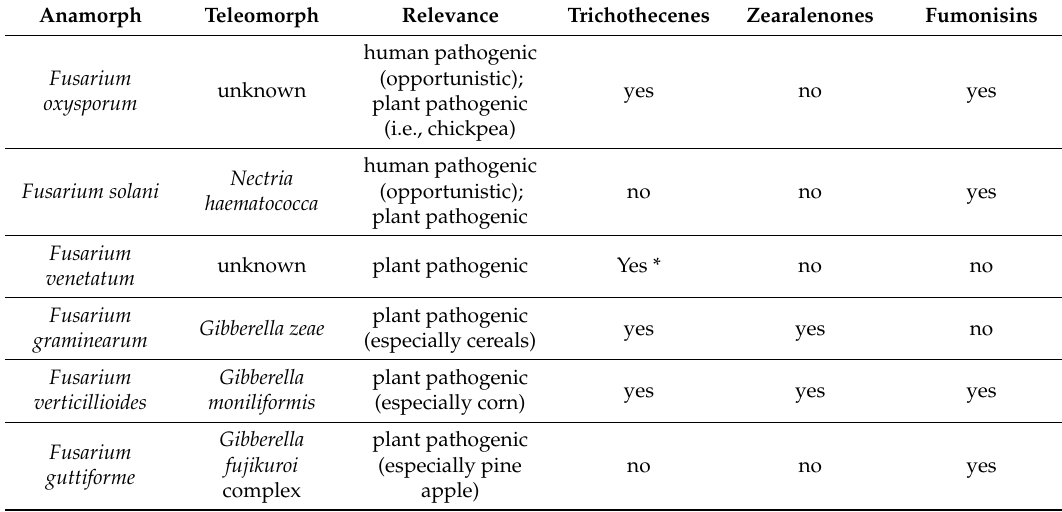
Table 1. Characteristics of some relevant Fusarium species, including their ability to produce some relevant